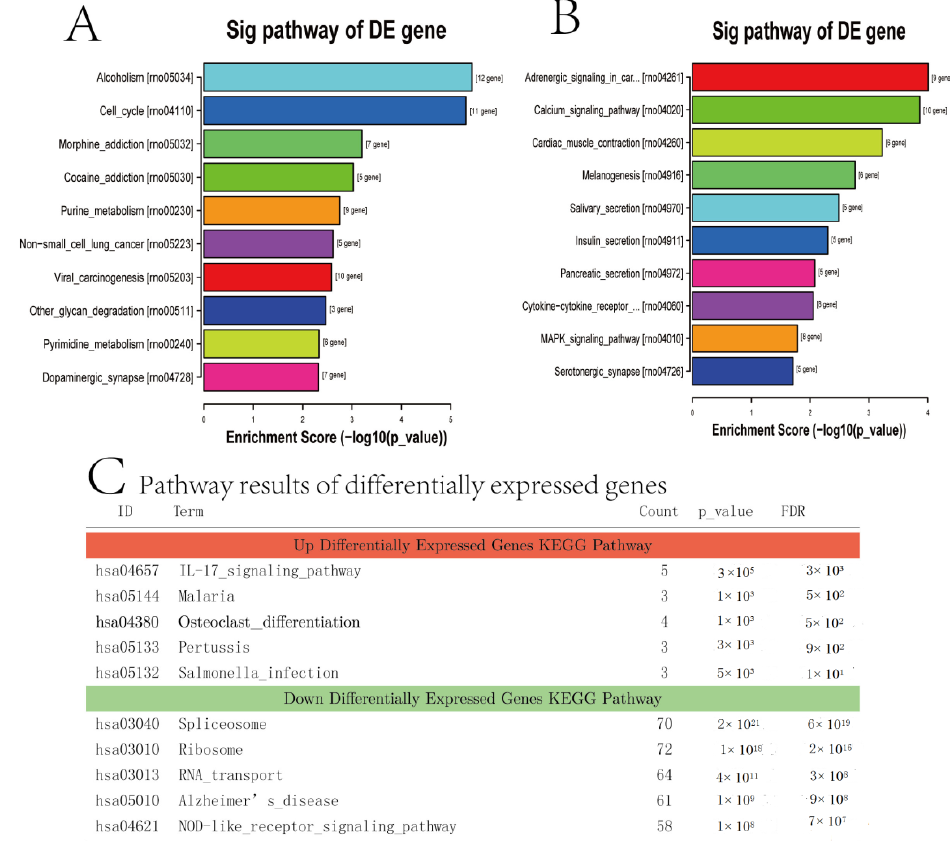
Figure 6. Enrichment analysis of the KEGG pathway. ( A , B ) The KEGG pathway analysed the top 10 item bar diagrams. In p -value order from low to high, the ordinate represents the p -value ( − log10 transformation). ( C ) Pathway analysis of the first five pathways of significantly up- and downreg- ulated differentially expressed genes KEGG pathway. Pathway analysis is a functional analysis mapping genes to KEGG pathways. The p -value (EASE-score, Fisher- p -value or Hypergeometric- p - value) denotes the significance of the pathway correlated to the conditions. The lower the p -value, the more significant the pathway (the recommended p -value cut-off is 0.05). Upregulated differential expression gene KEGG pathway analysis results folder: Up; downregulated differential expression gene KEGG pathway analysis results folder: